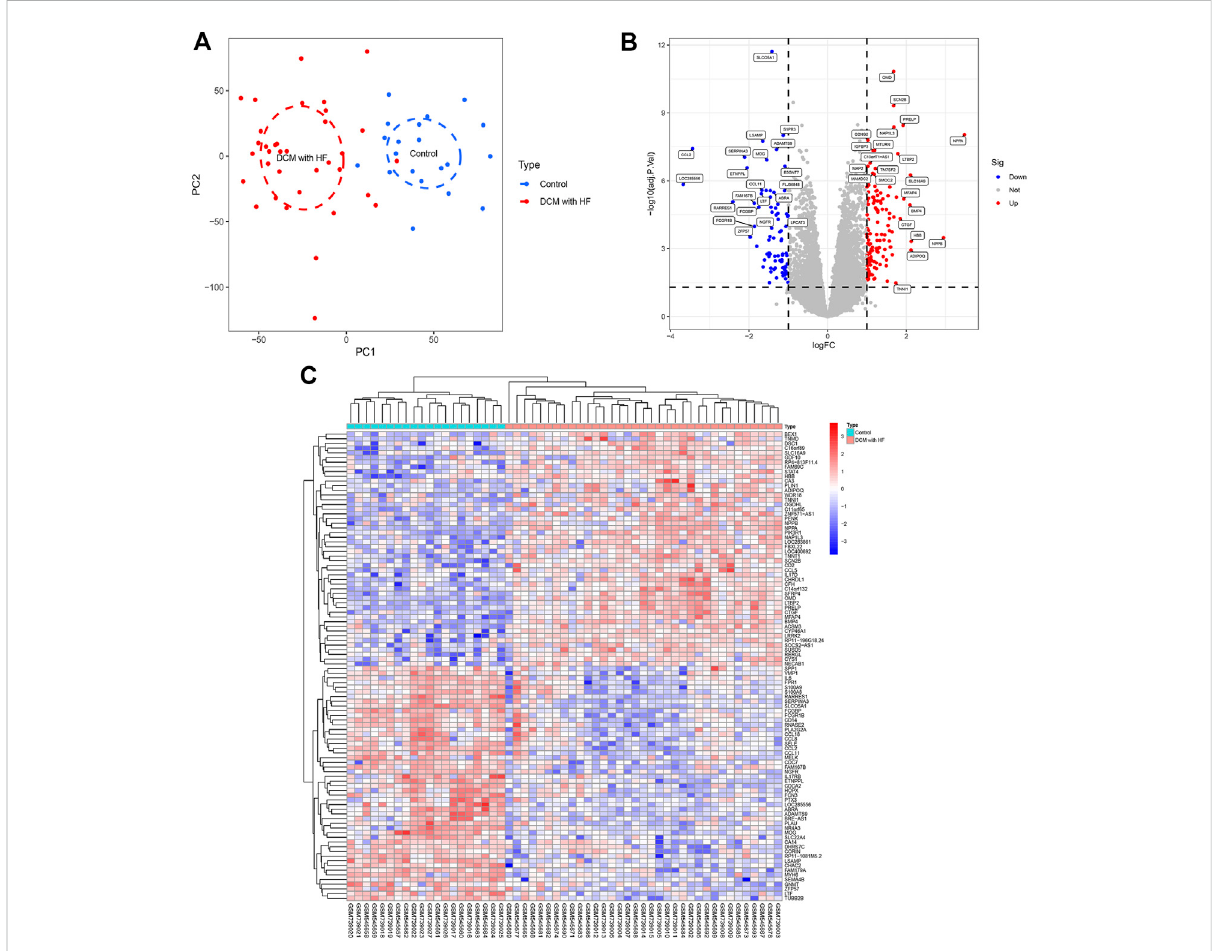
FIGURE 1 Data processing and identi fi cation of DEGs. (A) PCA score plot of the training group dataset after batch removal showing the difference between control and DCM with HF groups. (B) Volcano plot of DEGs. Red dots represent up-regulated genes and blue dots represent down- regulated genes. (C) Heatmap displaying a differential expression of the top 50 up-regulated genes and top 50 down-regulated